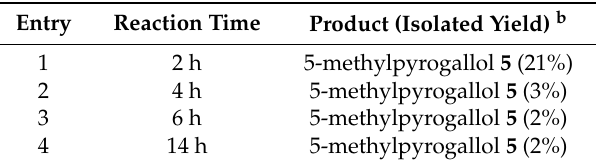
Table 2. Tentative dimerization of atranol at pH 9 a